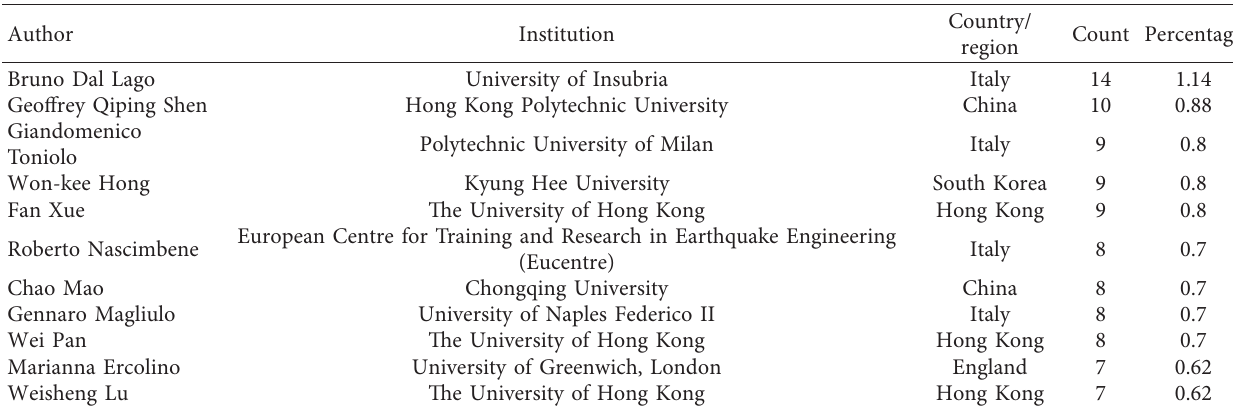
Table 1: Top 11 authors with high productive.